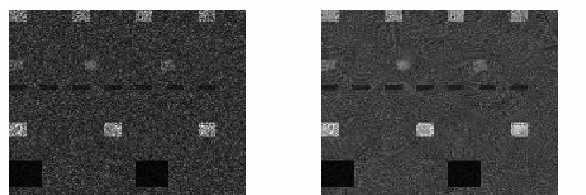
Figure 4. The resulted non filtered and filtered Reference